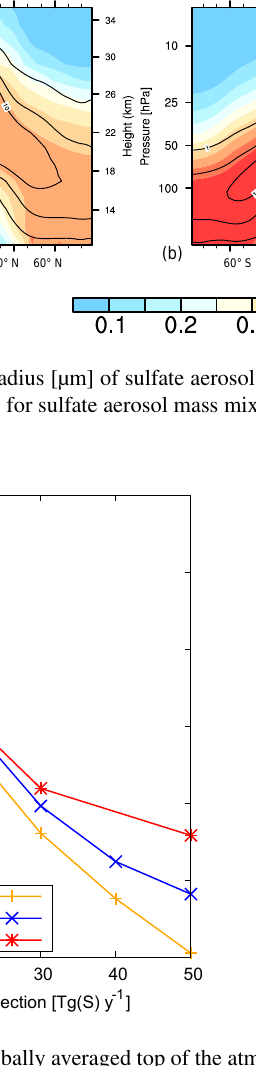
Figure 10. Injection rate against globally averaged top of the atmo- sphere radiative forcing (all sky) for simulations with low vertical resolution (GeoX) and high vertical resolution and two injection heights (XTg60 and XTg30).